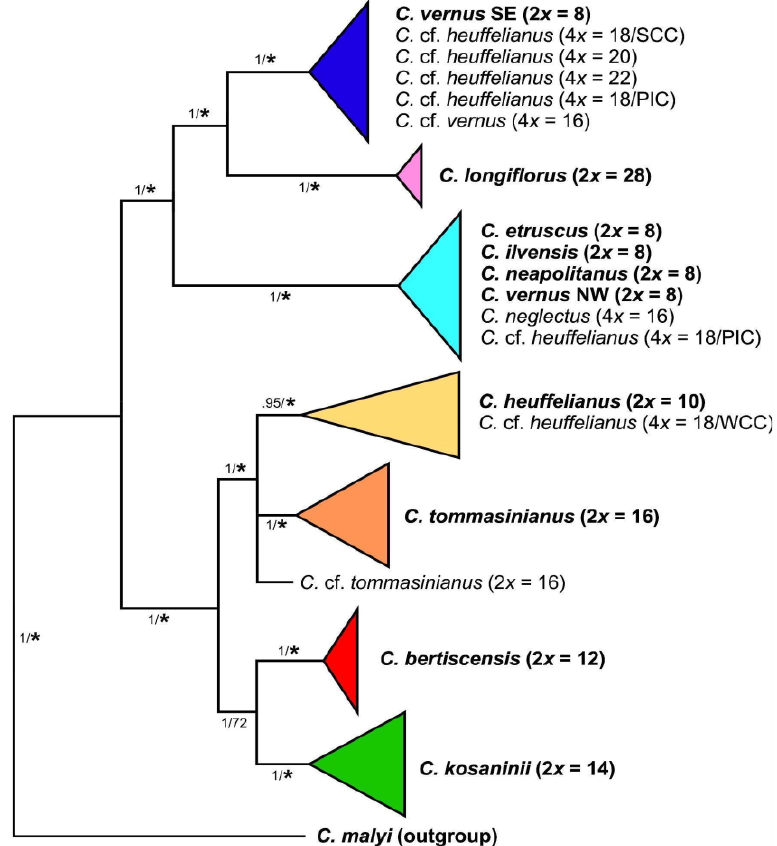
Figure 4. Schematic representation of relationships of species and cytotypes of Crocus ser. Verni obtained through Bayesian phylogenetic inference of sequences from two chloroplast regions (for original data see Supplementary Figure S4). Diploid accessions, as basic units in the series, are given in boldface. Numbers along branches indicate Bayesian posterior probabilities/maximum parsimony bootstrap values (≥50%), with asterisks for bootstrap support values >80%.